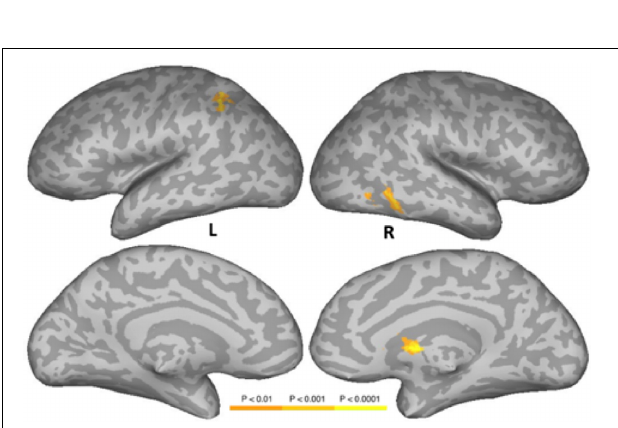
regions represent more activation for text whereas cool regions reflect more activation for nonwords. L, Left Hemisphere; R, Right Hemisphere.